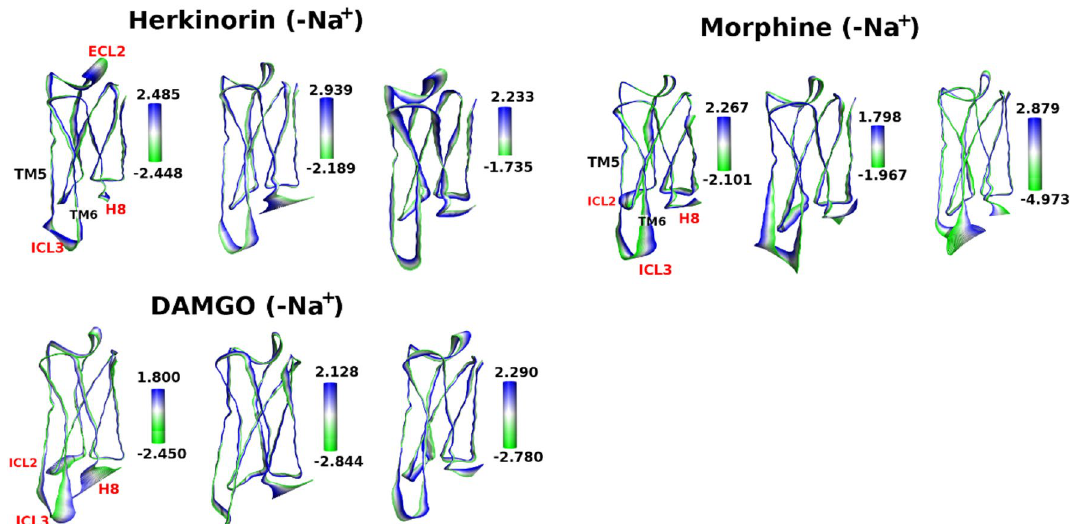
Fig. 4 Collective motions of μ-OR by systems (FMA). The most probable minimum (green) or maximum (blue) motions correlated with the RMSD backbone function. Predominant changes are colored in